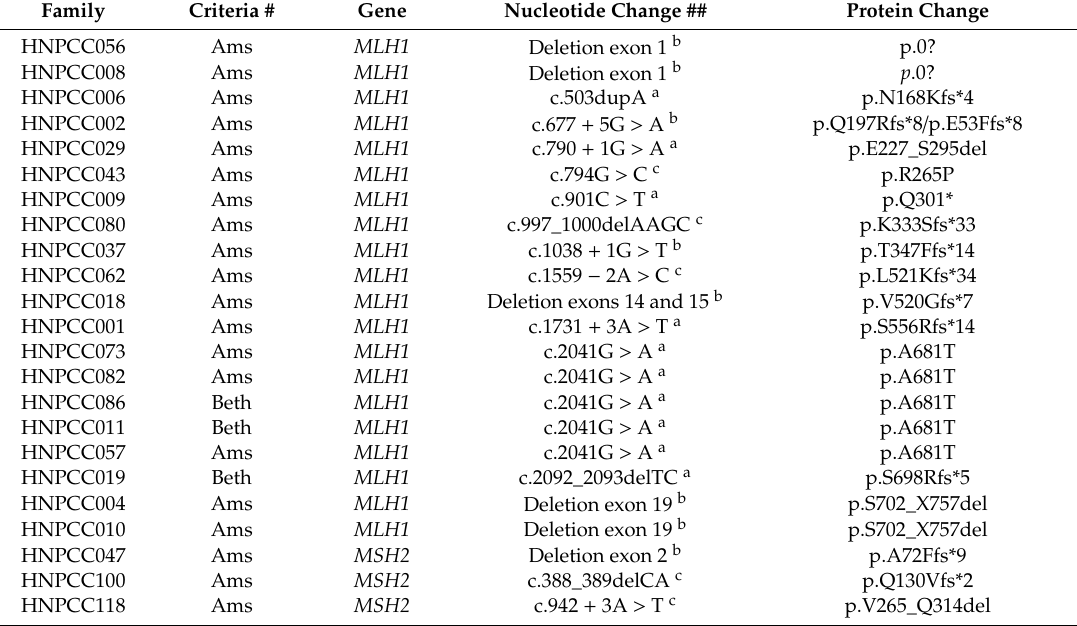
Table 1. Summary of class 4 and 5 path_MMR variants identified in 34 Chilean LS